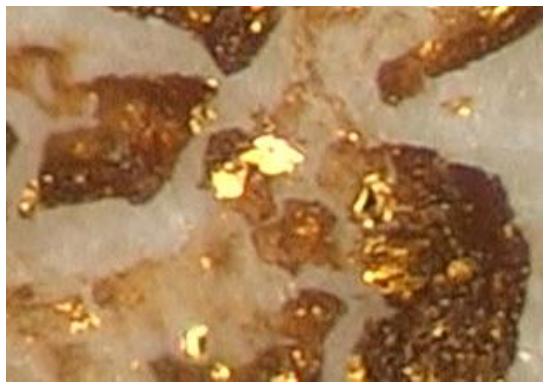
Figure 14. Change in the hydrochloric acid solution containing small amount of gold(III) after the addition of trace volume of persimmon extract liquid [32] (with permission for reuse from The Society of Chemical Engineers of Japan).